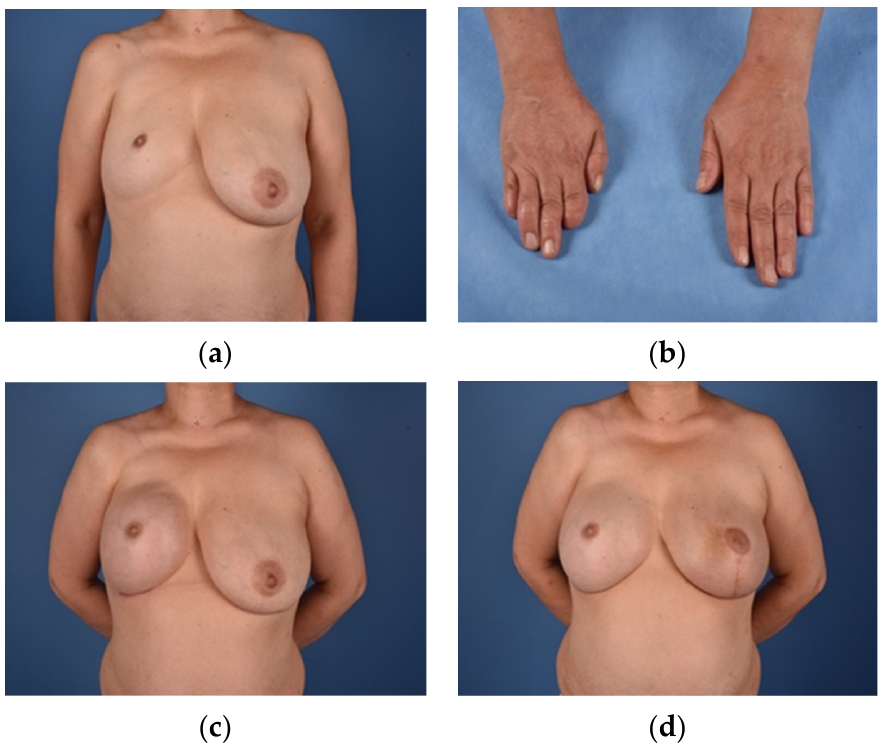
Figure 5. ( a ) = Female Patient (48) with Grade III deformity; ( b ) = Ipsilateral brachydactylia; ( c ) = Expander 5 months after implantation; ( d ) = Final result (8 months) after Implant reconstruction (485 cc), breast reduction mammoplasty of the contralateral breast and singular lipofilling (200 mL).